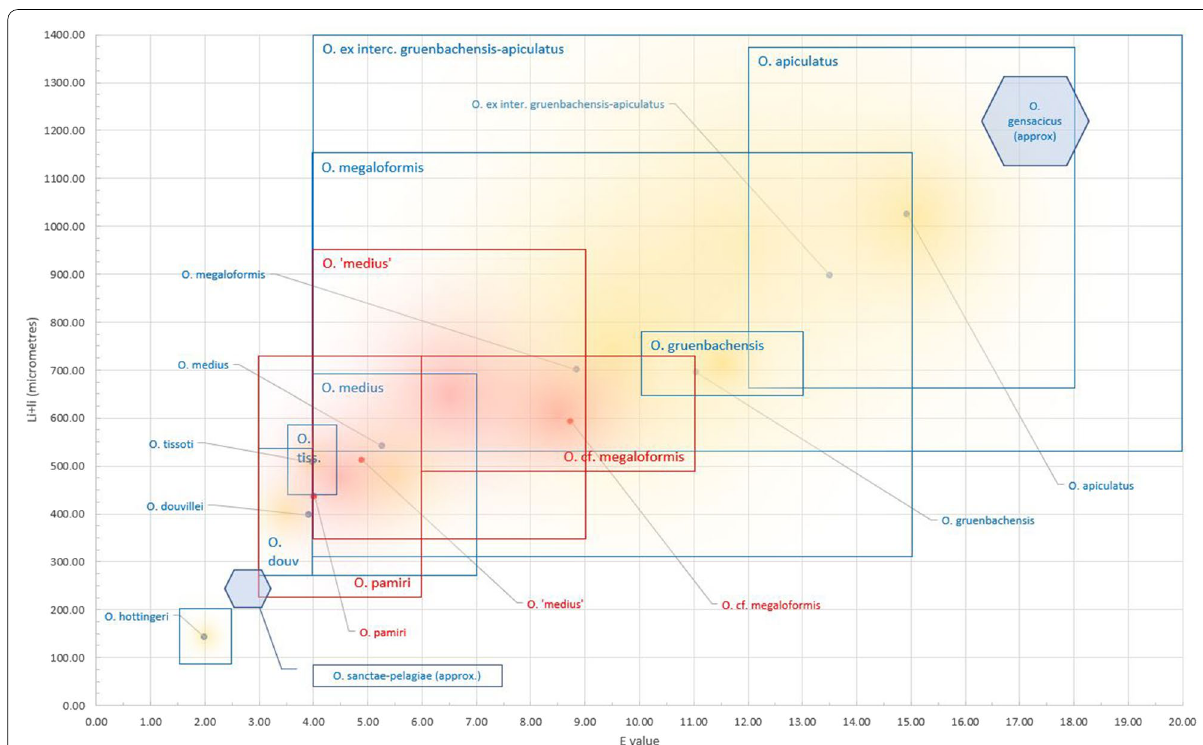
Fig. 7 Plot of “mean of means” values for Li li and E values for commonly accepted Orbitoides species (blue points, forming an evolutionary + sequence) and informal/new taxa which appear to show “retrograde” embryonic evolutionary features (red points). Blue and red rectangular envelopes describe the max and min range values for these mean parameters. Data used is a compilation of that from Caus et al. (1996), Mitchell (2005) and this paper. The approximate relative positions of other commonly accepted species ( O. sanctaepelagiae and O. gensacicus ) are shown on this evolutionary line, although no data were available for these taxa from the quoted